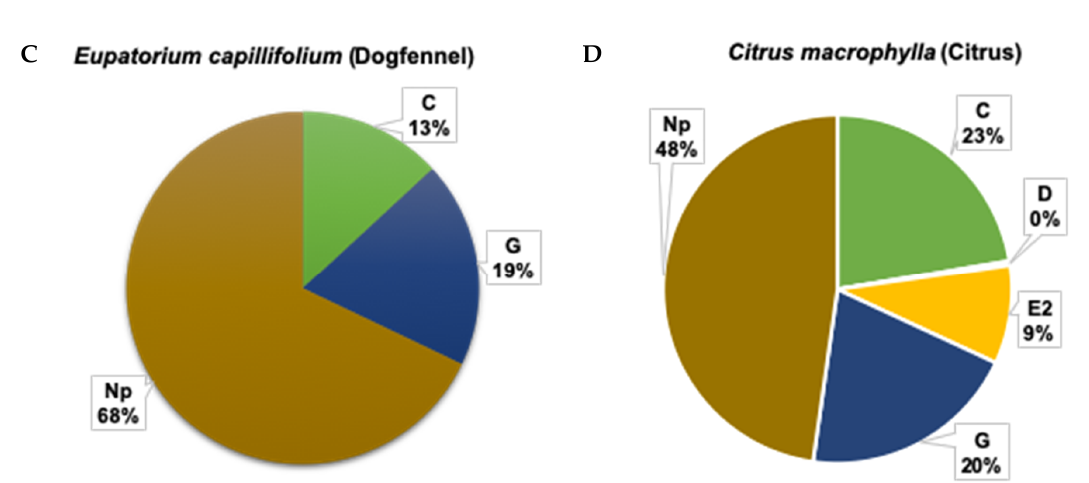
Figure 3. Percent duration of each feeding activity (C, D, E1, E2, G, and Np) performed by Diaphorina citri adults on various weed species and citrus during 18 h EPG recordings. ( A ) Primrose, n = 18; ( B ) Spanish needle, n = 22; ( C ) Dogfennel, n = 18; and, ( D ) Citrus macrophylla , n = 22.